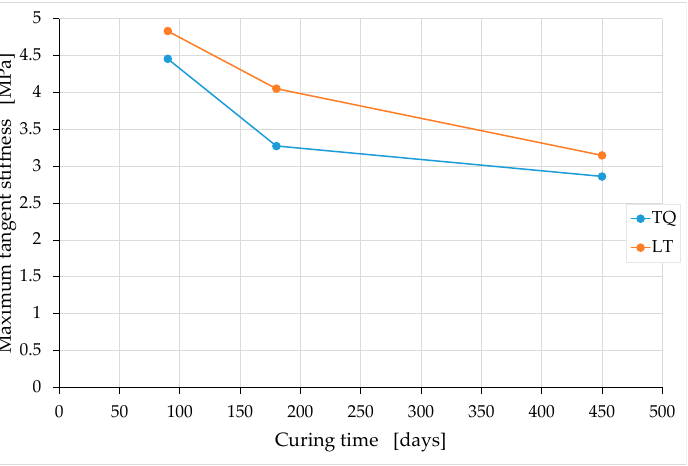
Figure 20. Trend over time of the average values of maximum tangent stiffness: TQ and LT mixes.